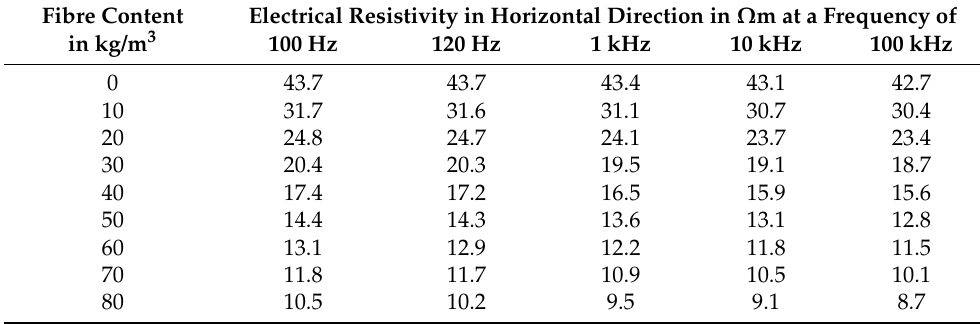
Table A21. Results of the resistivity measurements of the concrete mixture 32-60-300-00-F1.